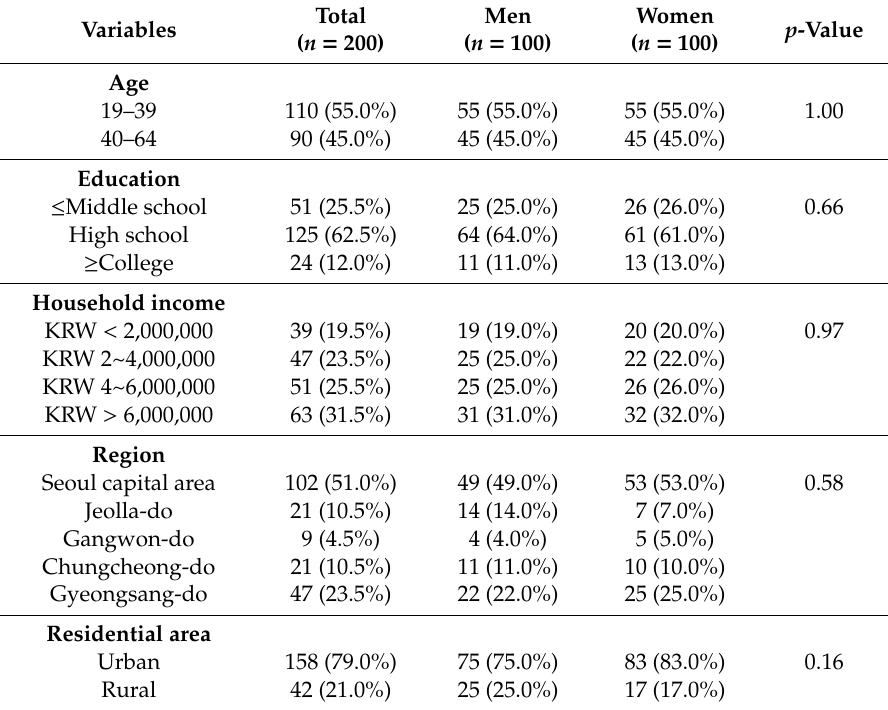
Table 4. Demographic characteristics of the participants in the main